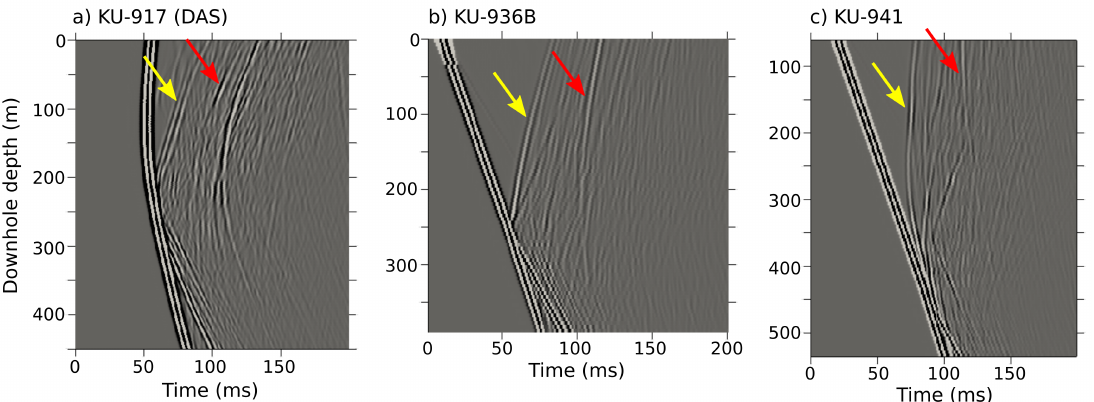
Figure 8. Synthetic VSP shots obtained from seismic forward modeling for virtual receivers along borehole KU-917, DAS configuration ( a ), KU-936B ( b ) and KU-941 ( c ). Arrows indicate reflections from the KAL-OME contrast (yellow) and the S/MS deposit (red) (compare to Figure